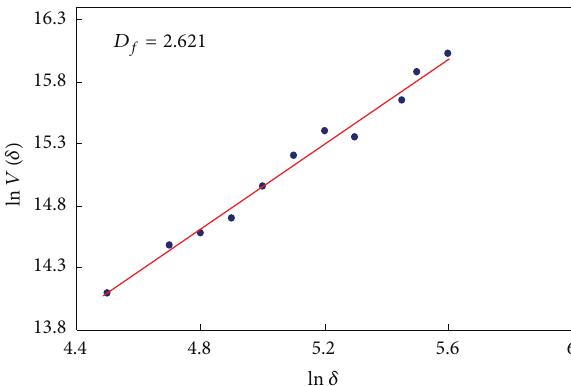
Figure 2: Fractal dimension calculation for cell body of the open cell polyurethane